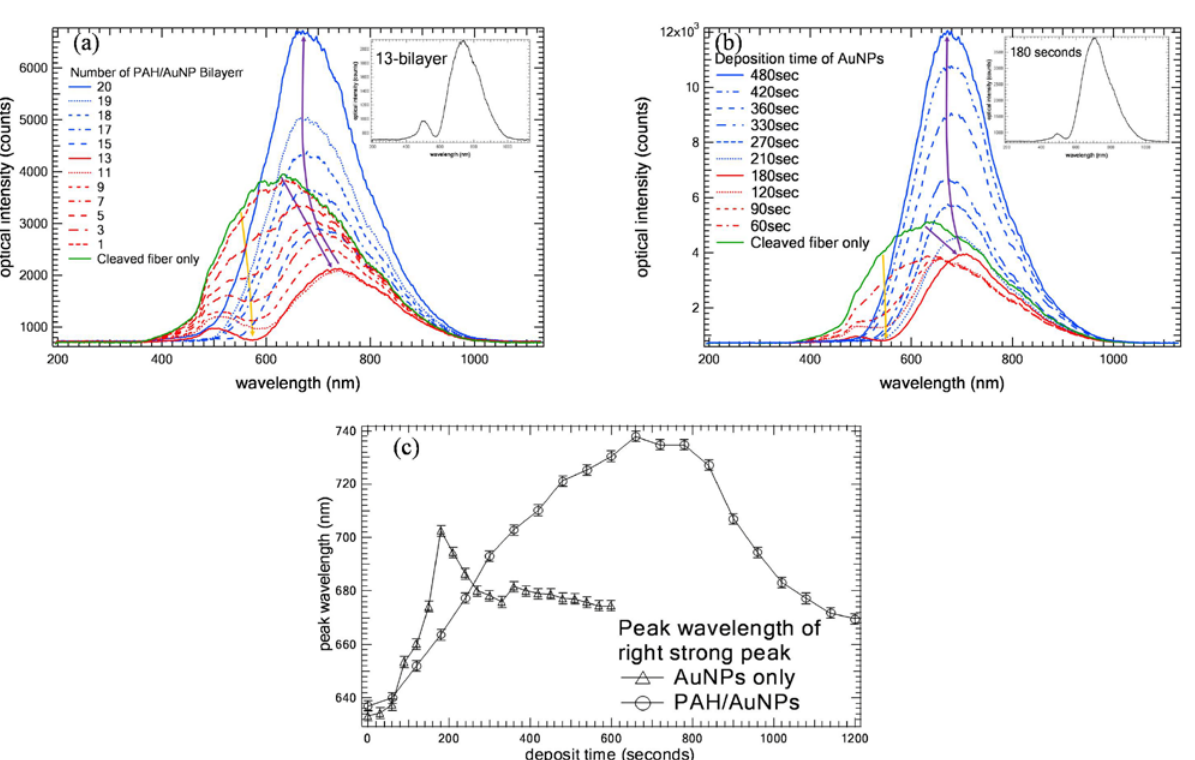
Figure 3. (a) Reflection spectrum of fiber probe as a function of number of coated PAH/AuNPs (16 nm) ISAM bilayers measured in air, AuNPs and PAH are alternately deposited every 30 seconds. Yellow arrow and purple arrow indicate the attenuation valley variation trend and the trend of the longer-wavelength strong peak shift as the number of bilayers increases, respectively; (b) After coated with one monolayer of PAH, fiber probe is immersed in AuNPs colloid solution. Reflection spectrum of fiber probe is measured every 30 seconds in air. Yellow arrow and purple arrow indicate the attenuation valley variation trend and the trend of the longer-wavelength strong peak shift as the number of bilayers increases, respectively; (c) Wavelength shifts of longer-wavelength strong peak in (a) and (b) as function of deposition time in PAH/AuNPs and AuNPs,